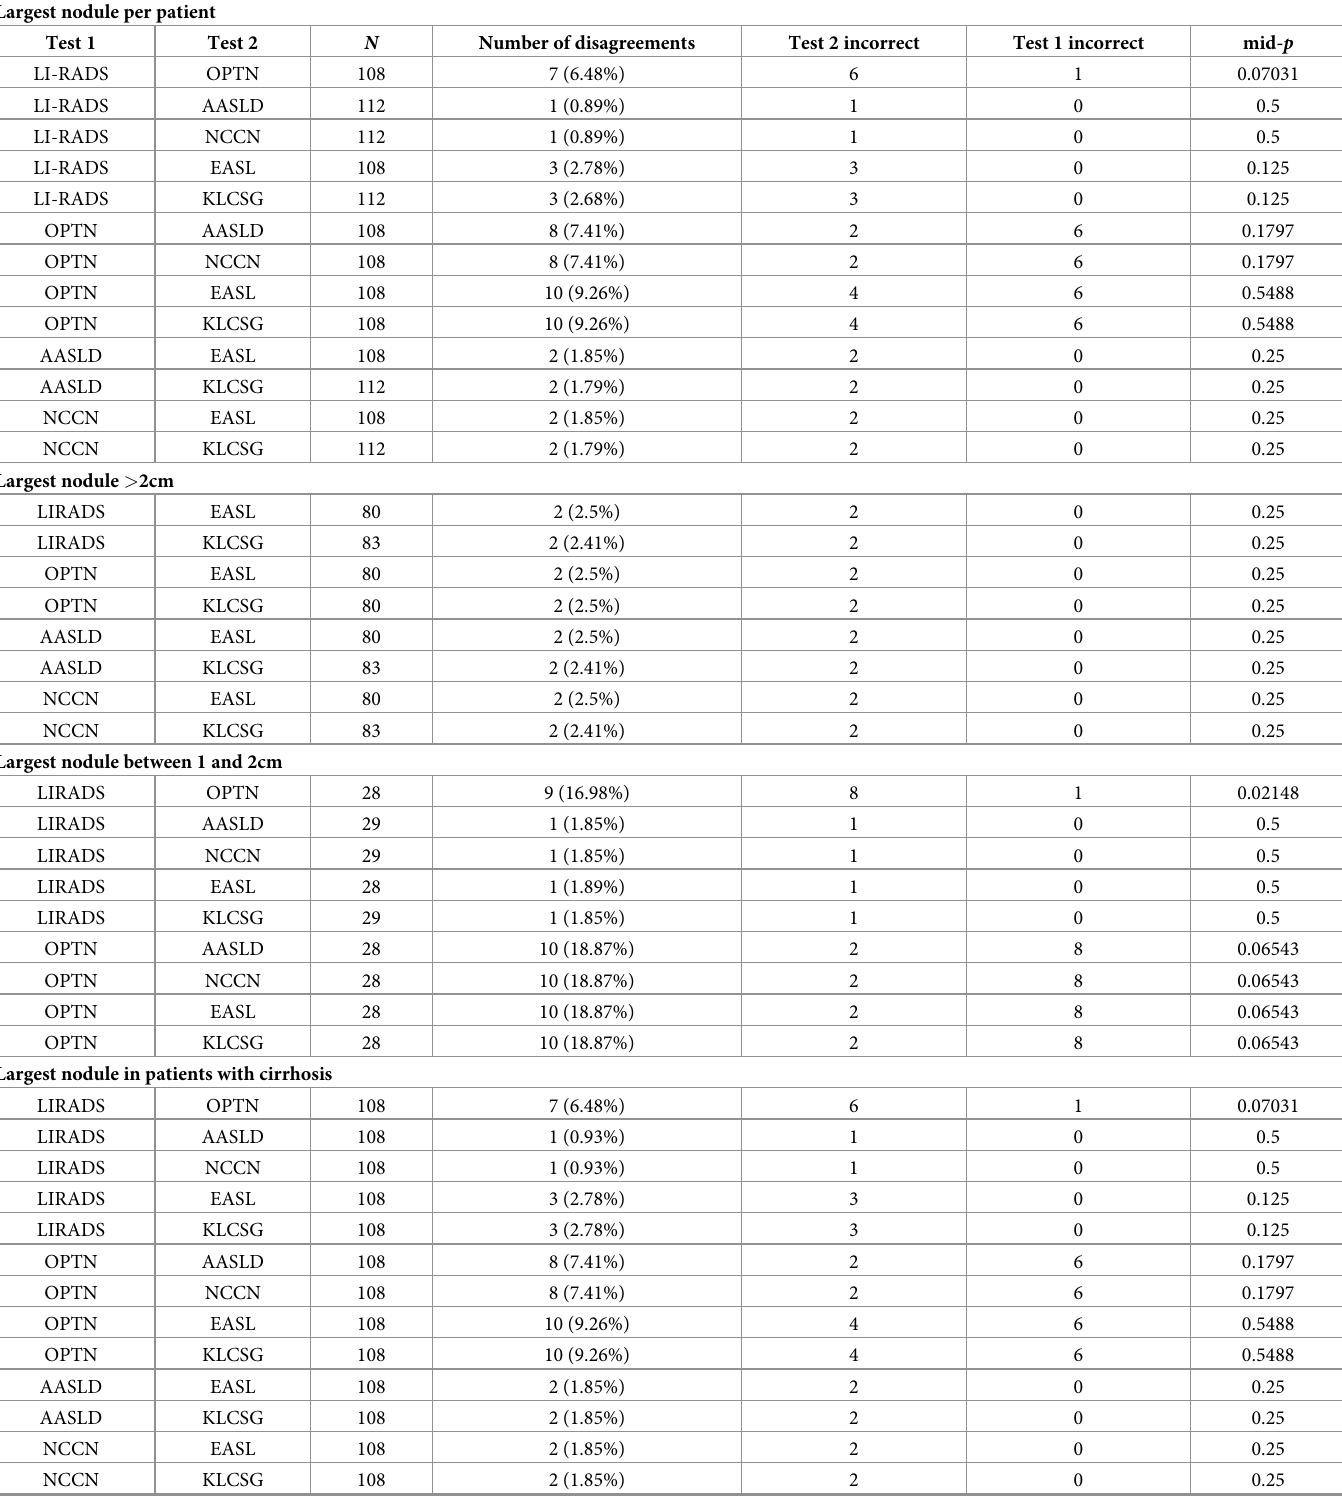
Table 5. Discordance